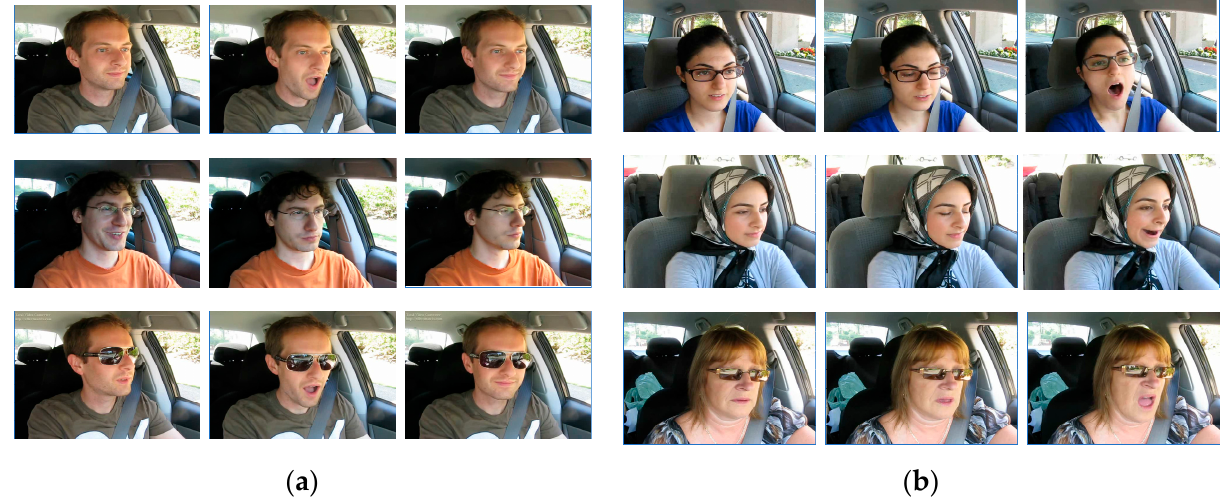
Figure 7. YawDD dataset: ( a ) Images of male drivers. ( b ) Images of female drivers.